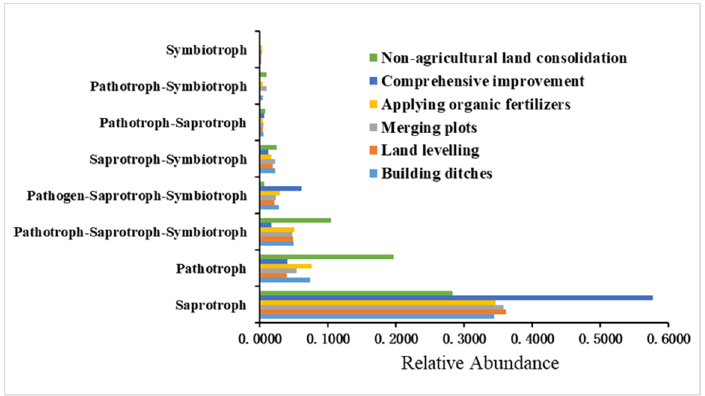
Figure 7. Functional types and relative abundance of fungal communities in soil samples between different groups.